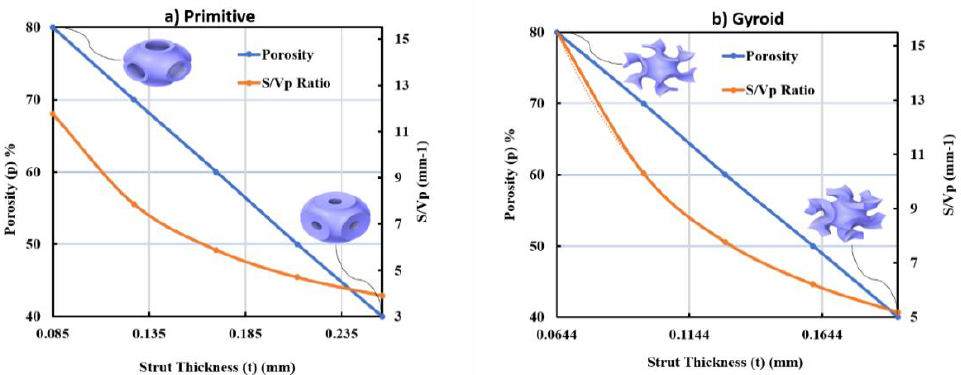
Figure 6. Porosity (p) and surface to volume ratio (S/V P ) versus strut thickness (t) for the respective unit cells ( a ) P ( b ) G.